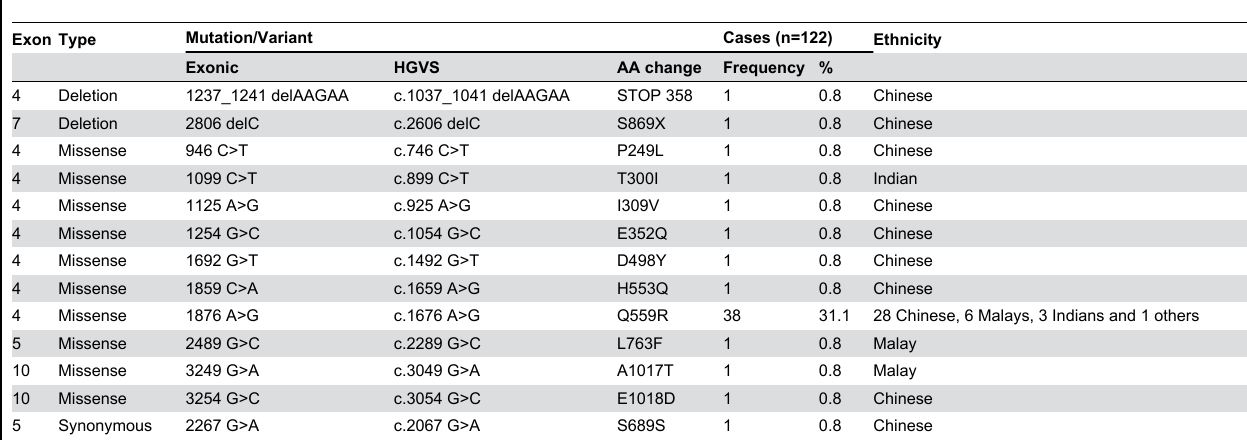
Table 2. List of 13 PALB2 genetic variants